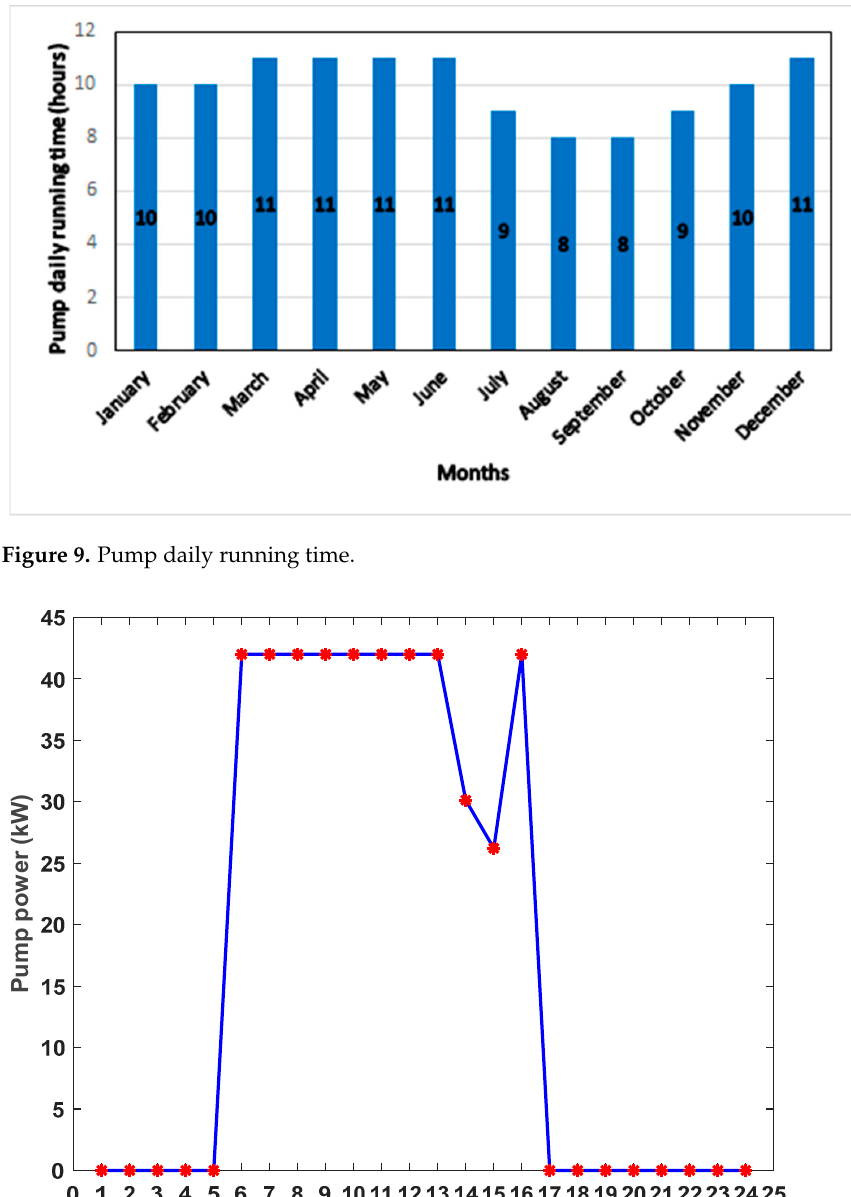
Figure 8. Pump power demand profile.